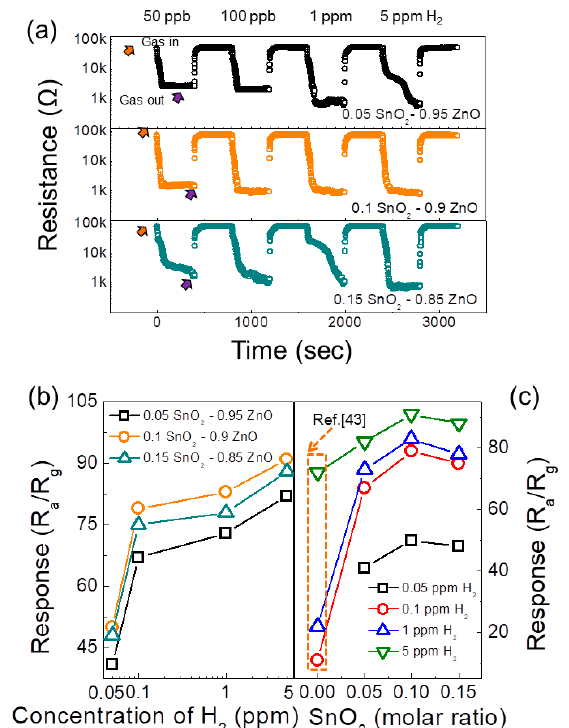
Figure 5. ( a ) Dynamic response curves of SnO 2 ‐ loaded ZnO NFs gas sensors to 50 ppb, 100 ppb, 1 ppm and 5 ppm H 2 gas at 300 °C. ( b ) Calculated hydrogen response as a function of hydrogen concentration. ( c ) Calculated hydrogen response as a function of SnO 2 loading amount.